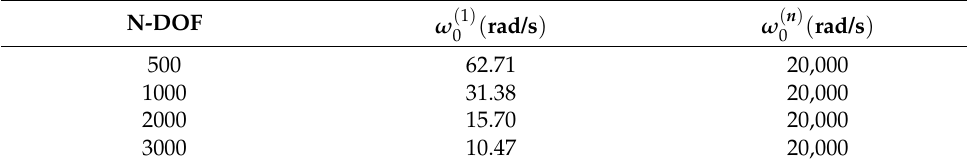
Table 3. Initial and highest natural frequencies.